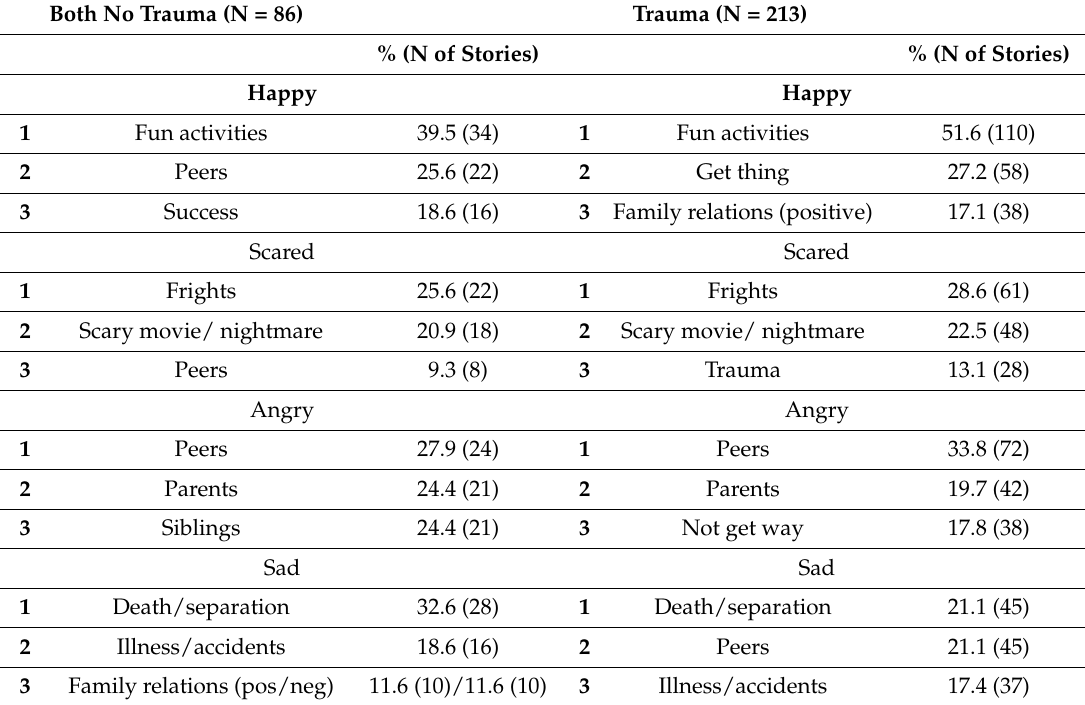
Table 3. Most common topics per emotion between dyads with and without trauma exposure. Both No Trauma (N = 86)